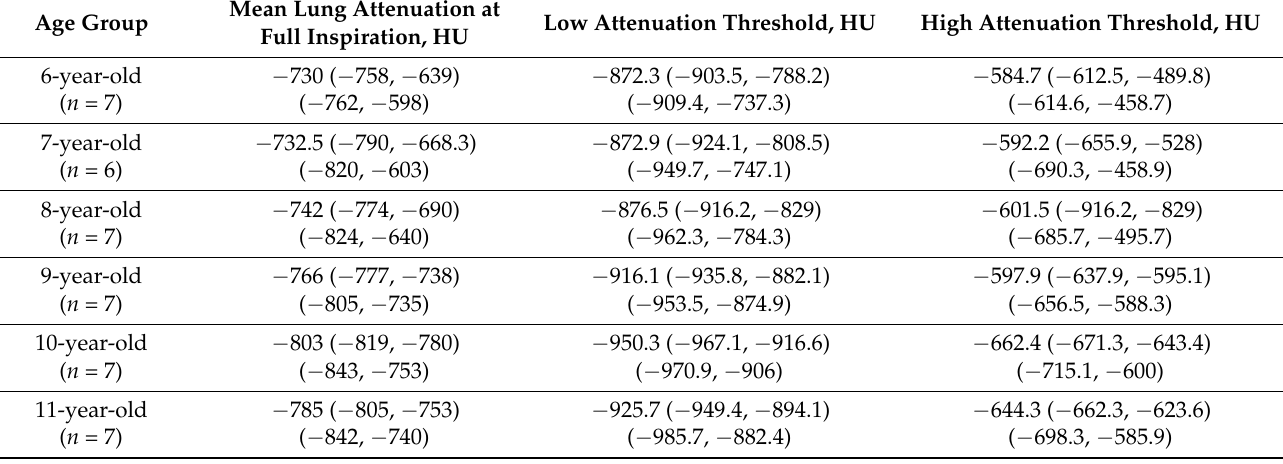
Table 1. Summary of mean attenuation values at full inspiration and low and high attenuation thresholds for individual subjects according to age group.